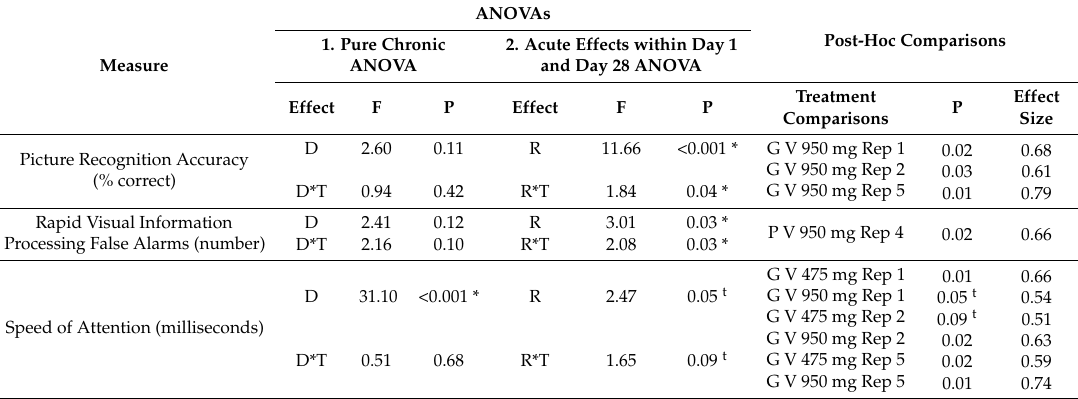
Figure 6. Speed of attention. Mean ( ± EM) change-from-baseline performance on “speed of attention” (derived from collapsing reaction time data from “numeric working memory”, “choice reaction time” and the “Rapid Visual Information Processing” task) on Day 1 (repetition 1 = post-dose repetition 1 on Day 1, repetition 2 = post-dose repetition 2 on Day 1) and following 28 days of supplementation with 475 mg Sideritis scardica (SS), 950 mg SS, active control (240 mg Ginkgo biloba ) or placebo control (repetition 3 = pre-dose baseline on Day 28, repetition 4 = post-dose repetition 1 on Day 28 and repetition 5 = post-dose repetition 2 on Day 28). * p < 0.05, ** p < 0.01 and t = trend. Table 1. ANOVA and Bonferroni corrected post-hoc t -test results summary for significant cognitive outcomes. Table summarises the day (D) and day × treatment (D*T) interaction effects from the chronic ANOVAs (effects compared across treatments at pre-dose on Day 28) and repetition (R) and repetition × treatment (R*T) interaction effects from the acute ANOVAs (effects within Day 1 and Day 28) as well as the Bonferroni corrected post-hoc t -tests and effect sizes from the latter for the three significant cognitive outcomes. Here, G = Ginkgo biloba and P = placebo versus (V) the Sideritis scardica (475 mg and 950 mg) treatments. ANOVAs Measure